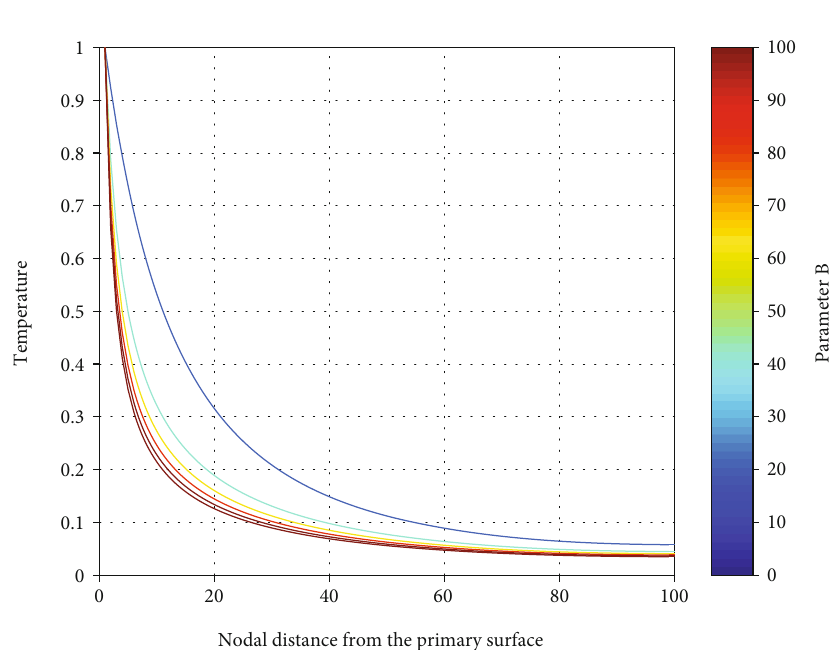
Figure 10: Thermal radiation in fl uence